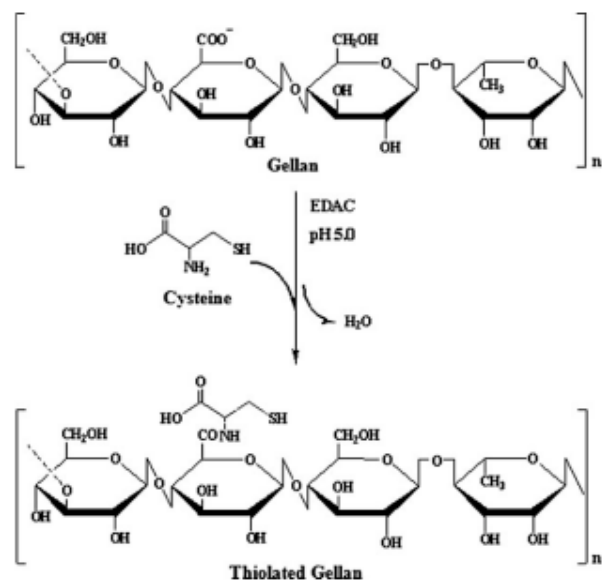
Figure 13. Thiolation reaction of deacetylated gellan. Reprinted with permission from [96]. Copyright 2022, John Wiley & Sons, Inc.